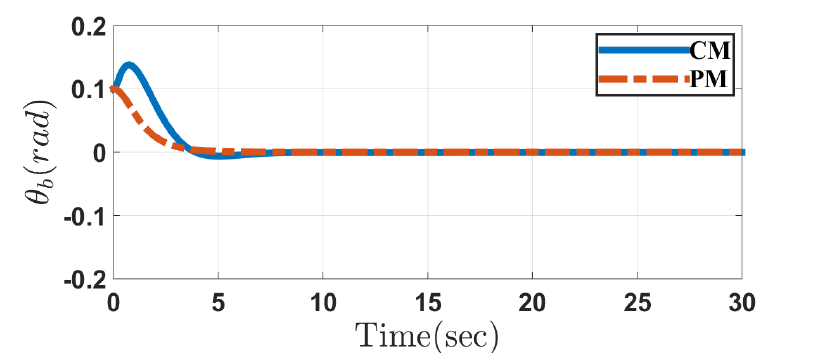
Figure 12. Pitch angle of system in the conventional method (CM) and the proposed method (PM) in Case